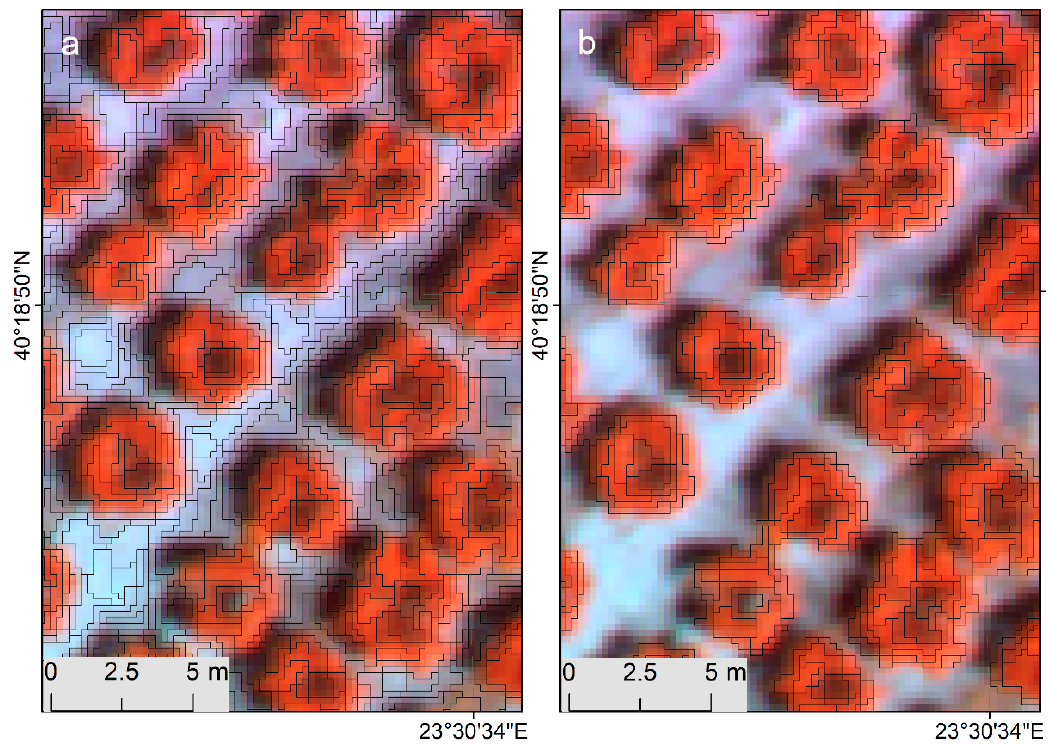
Figure 3. Segmentation and classification results: ( a ) close view of the segmentation; ( b ) objects classified as ‘Olive trees’ (in the same extent); both layers are overlaid on a false-colour composite of the multiSPEC 4C image.